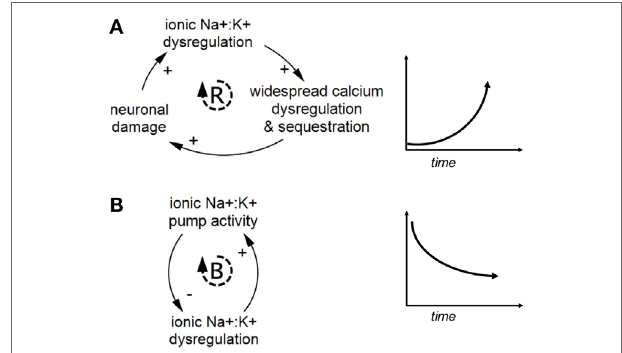
FigUre 4 | Within-scale and cross-scale feedback loops. Generic feedback loops are shown across four scales of organization relevant to concussion pathophysiology and recovery. Some loops occur within a given scale, and others span multiple scales.